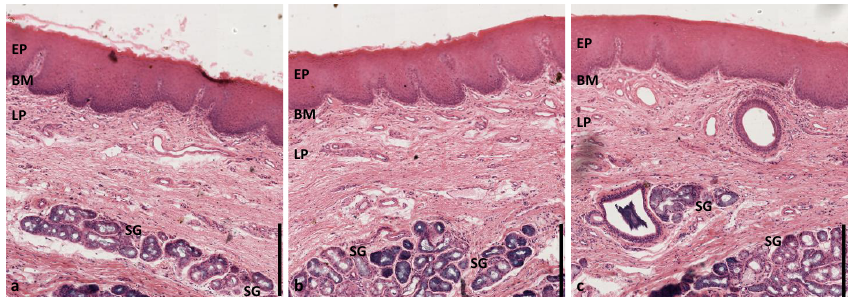
Figure A9. Supplementary HE stained histological cross sections of the mucosal tissue of the human soft palate [44]. EP: epithelium, BM: basement membrane, LP: lamina propria, SG: salivary gland. Scale bar: 200 µ m.